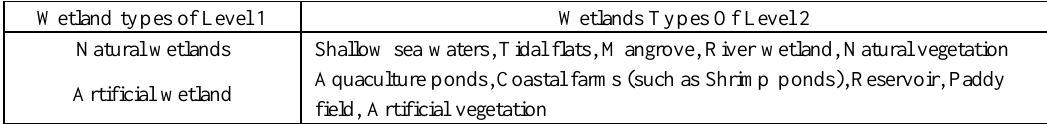
Table1. Classification systems of Qinzhou Bay